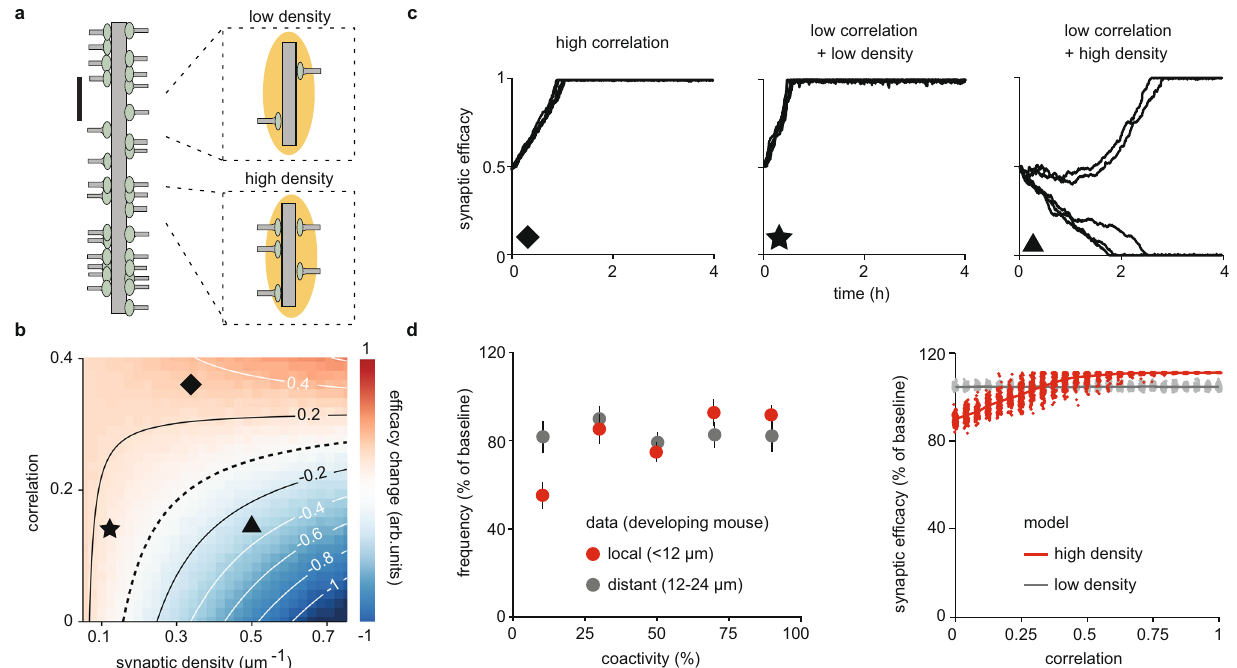
Fig. 2 Relating synaptic ef fi cacy change to synaptic density and input correlation. a Schematic with randomly distributed synapses along a linear dendritic branch. All synapses receive Poisson input trains with identical pairwise correlations. Scale bar is 20 μ m. b Average instantaneous change in synaptic ef fi cacy as a function of input correlation and density. Contour lines are determined by analytics, while colors by simulation, averaging over time and synapses (negative synaptic ef fi cacy change in blue, positive synaptic ef fi cacy change in red). c Evolution of synaptic ef fi cacy for fi ve different synaptic inputs at various combinations of density and correlation as in b (diamond, star, and triangle at densities 0.312, 0.125, and 0.5 μ m − 1 and correlations 0.15, 0.35, and 0.15, respectively). For low correlation and high density, individual ef fi cacy trajectories diverge due to random fl uctuations in the inputs. As some synapses depress, the effective density decreases (the triangle moves to the left from a depression to a potentiation region as shown in b ). d Left: Percentage change in synaptic transmission frequency after plasticity in the developing visual cortex relative to baseline as a function of coactivity for local (red) vs. distant (gray) synapses. Data from developing mouse visual cortex reproduced from ref. 6 and presented as mean values ± SEM ( n = 11 cells, pooled data of 352 synapses). Right: Percentage change in synaptic ef fi cacy (of baseline) in our model as a function of correlation for synapses at high density (0.5 μ m − 1 , a synapse every 2 μ m, red) and low density (0.05 μ m − 1 , a synapse every 20 μ m, gray). Dots represent individual